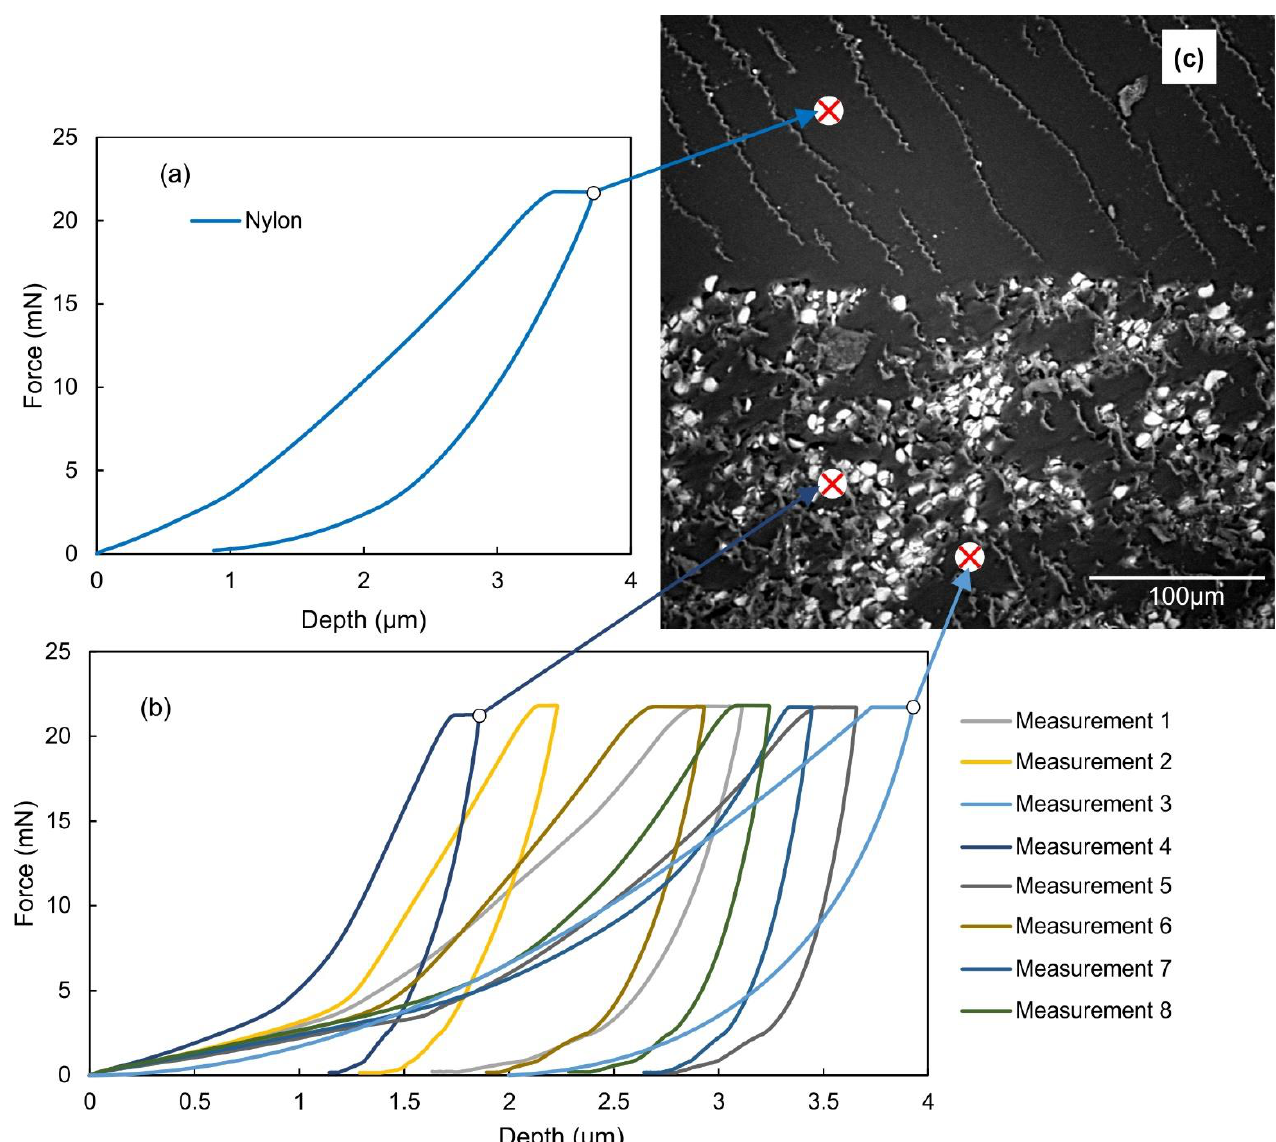
Figure 8. Comparison of typical load depth nanoindentation curves of ( a ) nylon and ( b ) nylon/Fiberglass, while (c) represents SEM of the scattered nanoindentation points on the cross section of nylon/Fiberglass specimens.